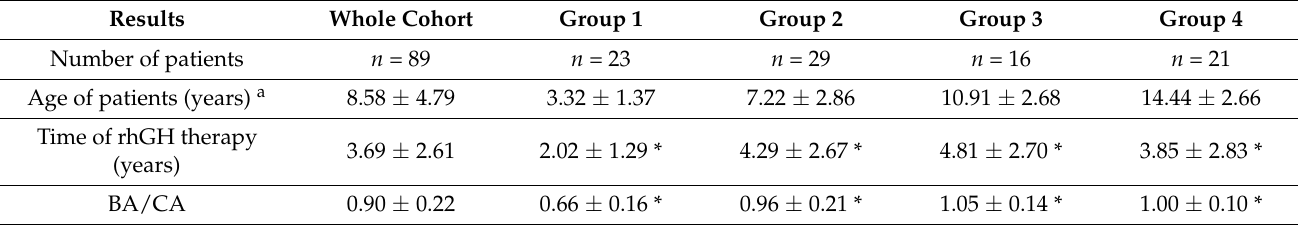
Table 5. Evaluation of BA/CA (mean value ± standard deviation score (SDS)) in the whole group and separate groups. Results Whole Cohort Number of